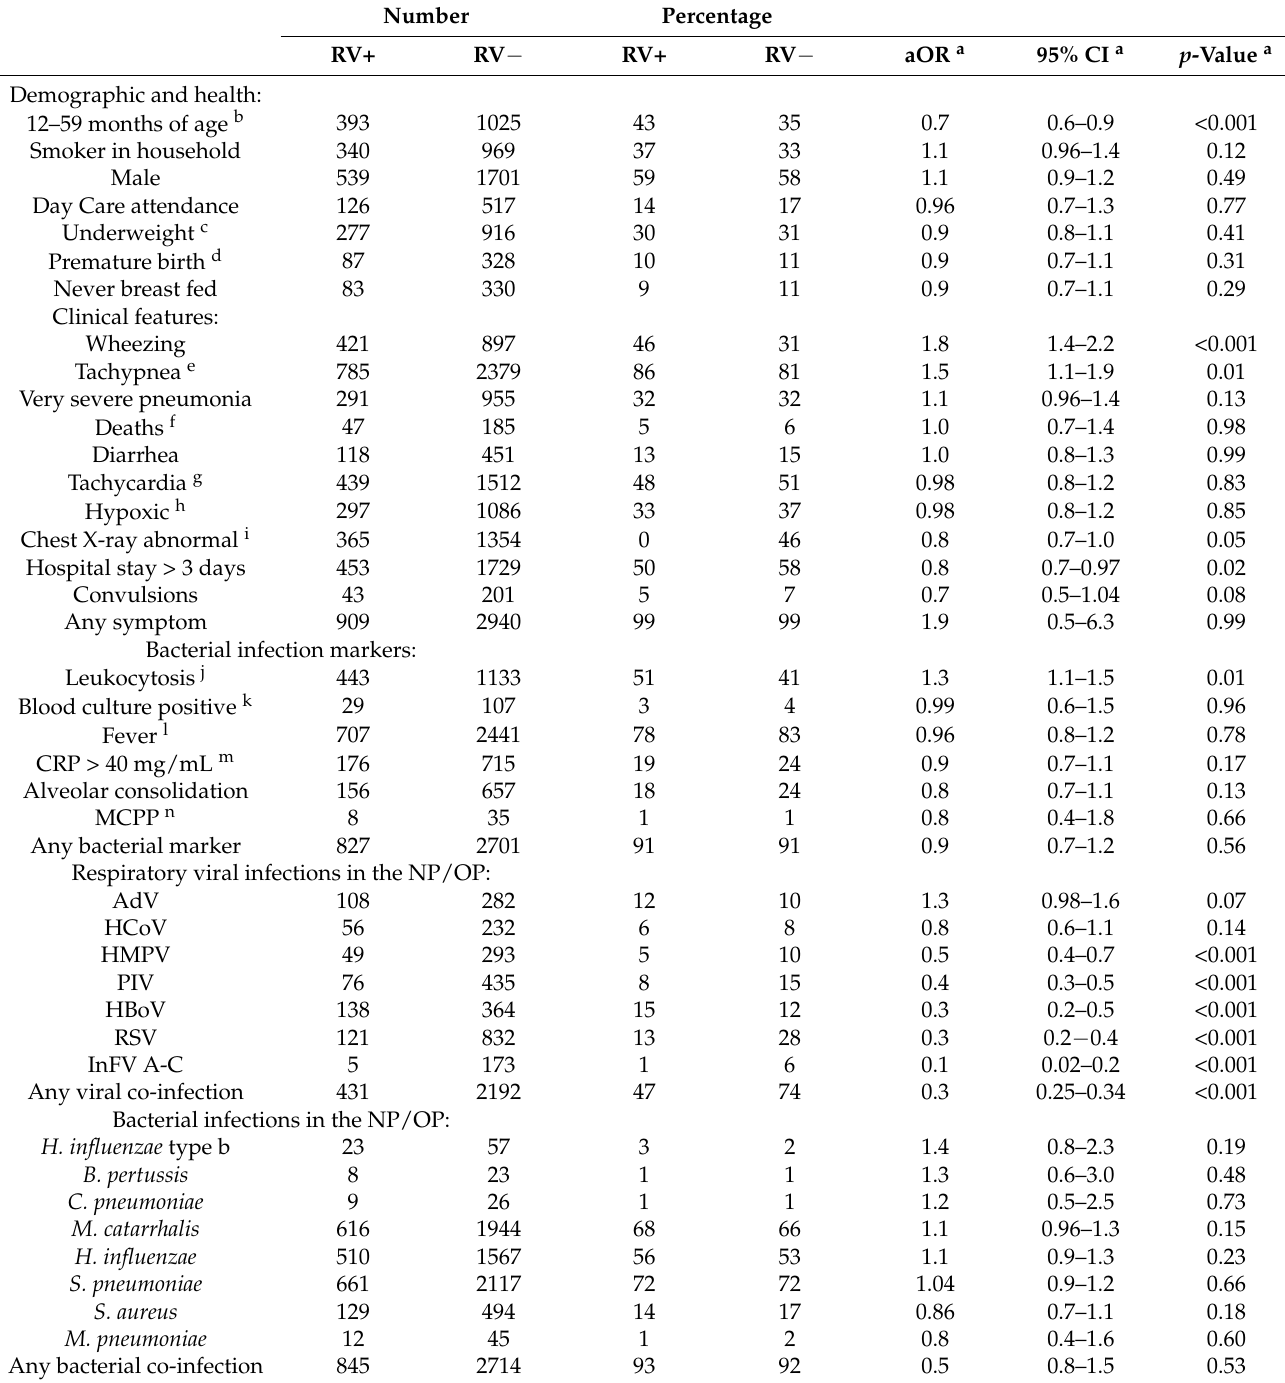
Table 3. Demographic and Clinical Characteristics and Co-Infections among Pneumonia Cases with ( N = 912) and without ( N = 2958) rhinovirus Infection, All PERCH